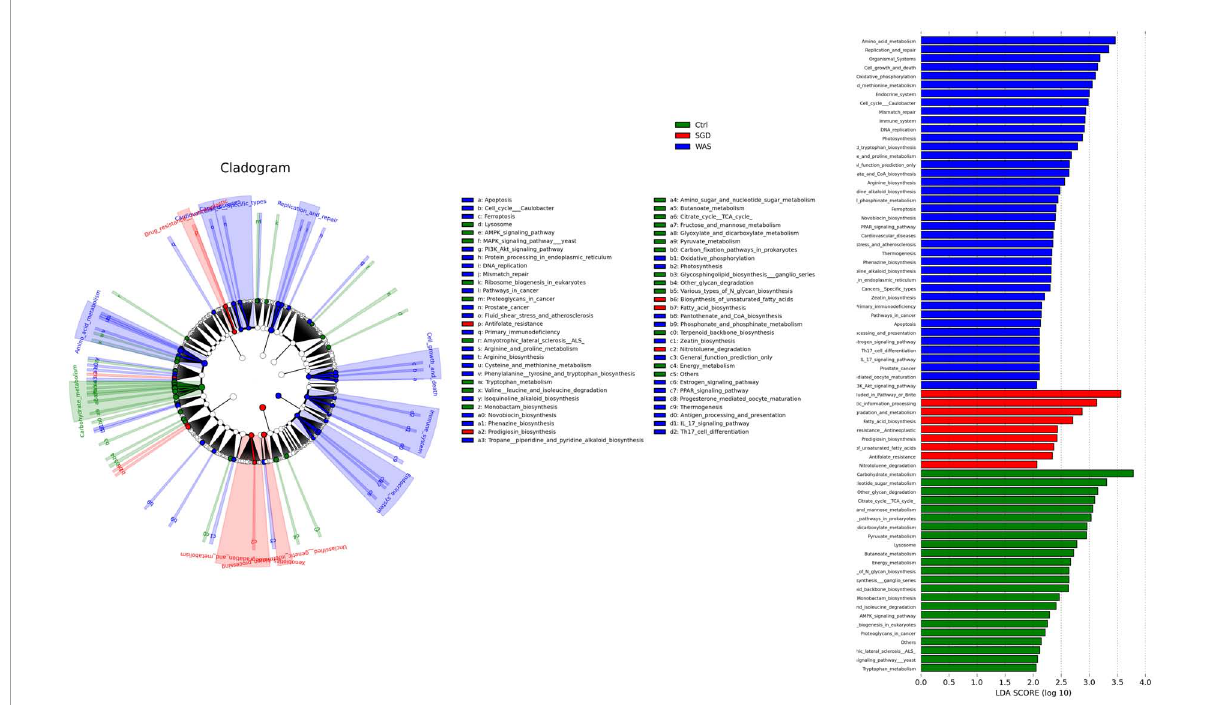
FIGURE5 Effect of SGD on microbial function. LEfSe analysis shows significantly different function between the three groups (left panel) and function with significantly different abundances (LDA scores > 2) (right panel) . LDA, linear discriminant analysis; LEfSe, LDA effect size.